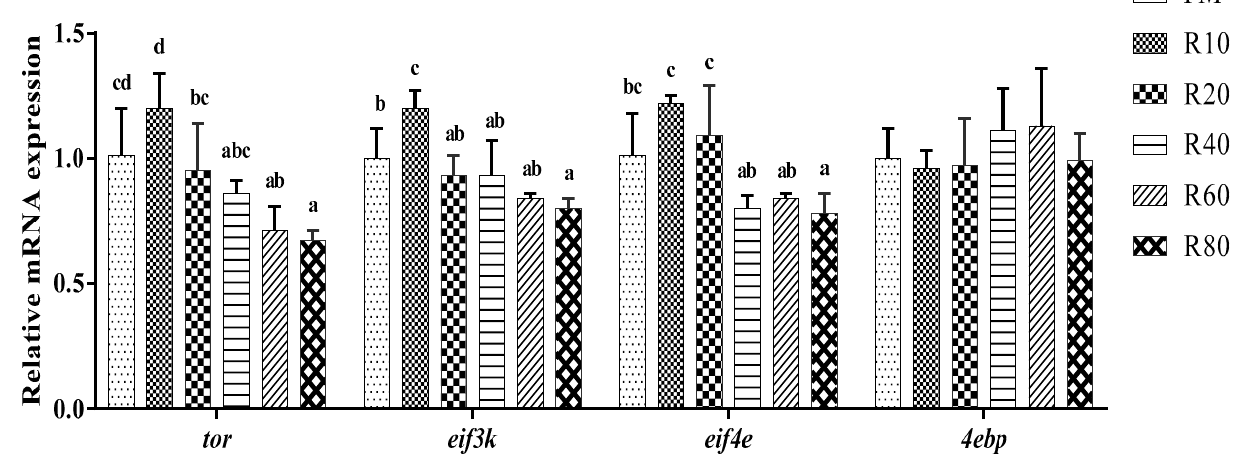
Figure 1. Effects of RPM replacing FM on hepatopancreatic protein synthesis relative mRNA expression for juvenile shrimp L. vannamei . Data are expressed as means ± SD ( n = 3). Different letters above a bar were statistically significant different among treatments ( p < 0.05).